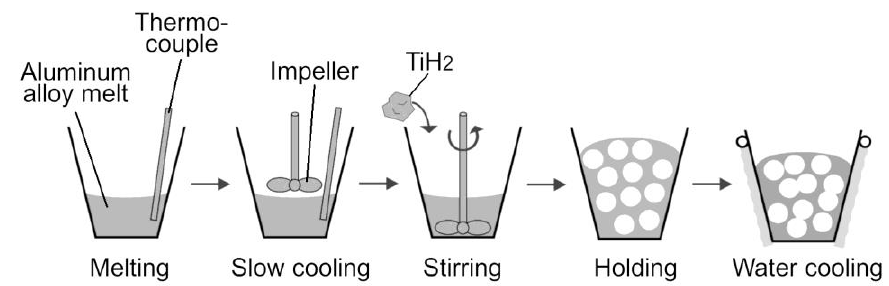
Figure 2. Scheme of the foaming process.